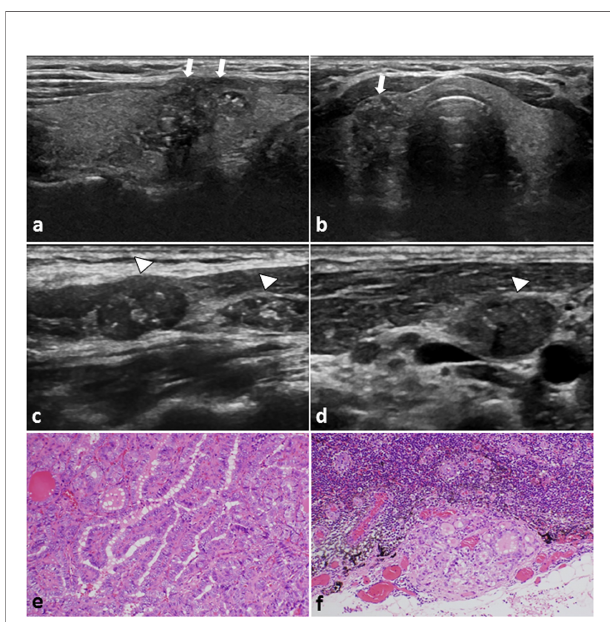
FIGURE 2 | A 29-year-old female PTC patient with positive CLNM. (A) Longitudinal sonogram and (B) Transverse sonogram showing a hypoechoic lesion in the right lobe of thyroid (arrows). The tumor size is 26×17×16mm, irregular, ambiguous, had multiple microcalci fi cation ( ≤ 1 mm) inside, and hard to be distinguish from the anterior thyroid capsule. Conventional US of the lymph nodes on (C) Level III and (D) level IV area of the neck. The lymph nodes were approximately rounded, lymphatic hilus structure disappeared, and with scattered calci fi cation inside (arrowheads). These features on US suggest the cervical lymph nodes metastasis. Histological examination con fi rmed the (E) thyroid papillary carcinoma in the right lobe, and (F) revealed lateral cervical lymph nodes metastasis. H-E ×